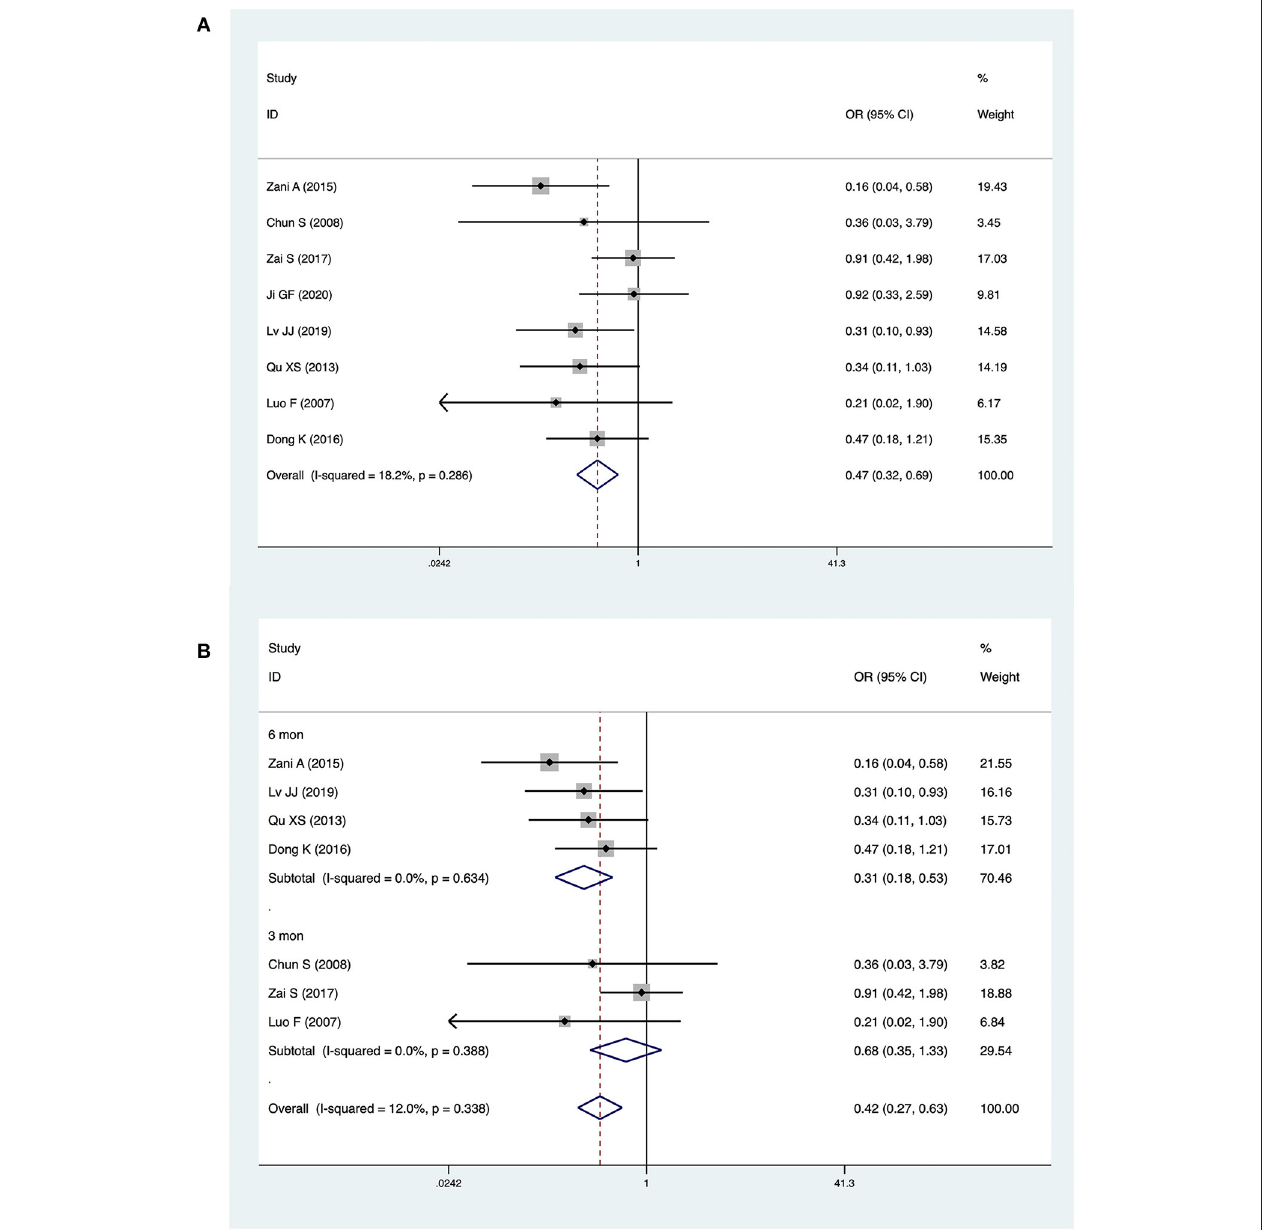
FIGURE 2 | Forest plot of jaundice clearance in CMV + BA vs. CMV − BA (A) , in 6 months and 3 months (B) .